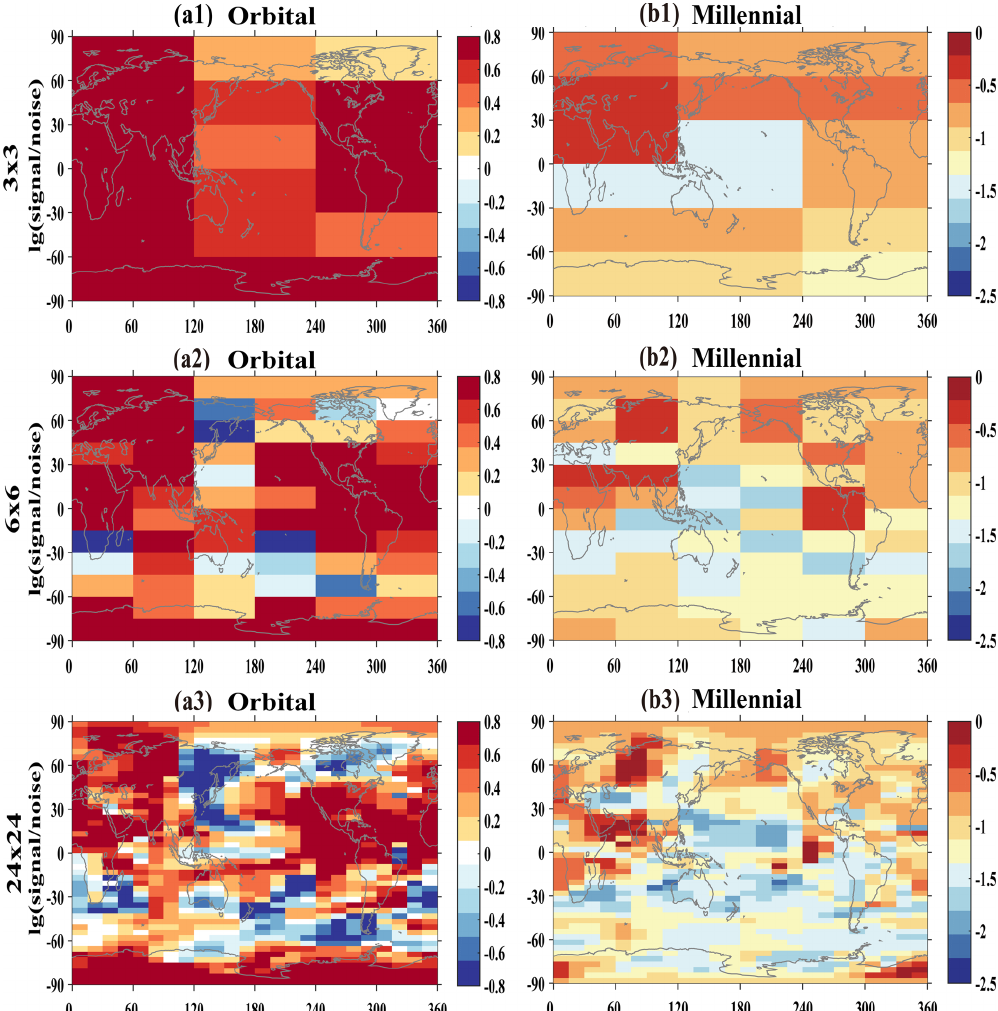
Figure 6. The signal-to-noise ratios on the orbital (a1–a3) and millennial (b1–b3) timescales derived from the ALL run. Here the signal is used by the orbital (millennial) variability variance, and the noise is used by the sum of the centennial and decadal variabilities variance. The numbers of 1, 2 and 3 are for the three representative spatial scales: f = 3, 6 and 24, respectively. In order to show the signal clearly, the log base 10 is taken on the signal-to-noise